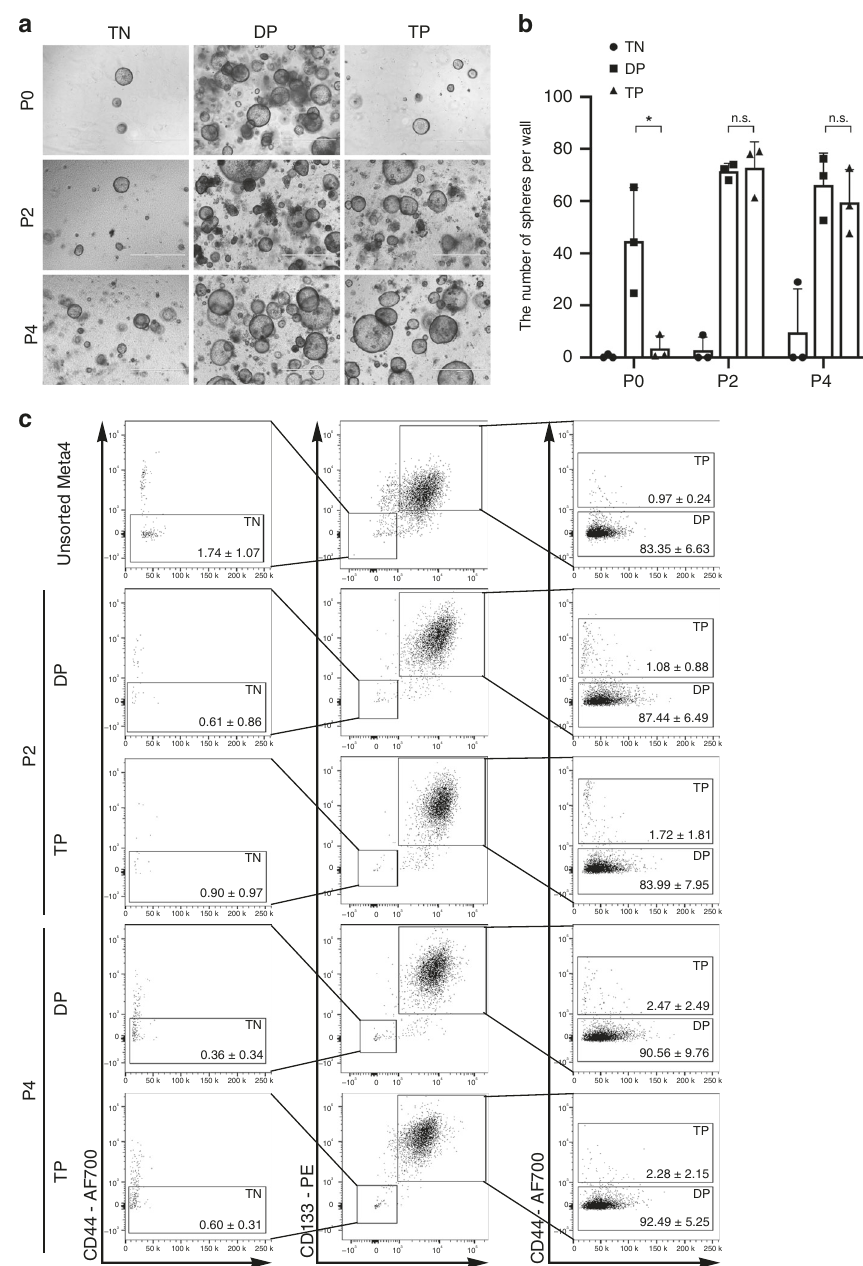
Fig. 9 Expansion of spheres derived from single dysplastic stem cells in Meta4. a Phase contrast images of spheres derived from isolated Triple-negative (TN), Double-positive (DP) or Triple-positive cells (TP) at passage 0 (P0), 2 (P2) and 4 (P4). Images were captured at about 1 week after plating (P0), at day 5 of P2, at day 5 of P4. TN (CD44neg/CD133neg/CD166neg) cells were isolated as a control population. Scale bars indicate 1000 μ m. b Quantitation of the number of spheres formed from the Triple-negative (TN), Double-positive (DP) or Triple-positive (TP) cells at P0, P2, and P4. Data are presented as mean values with standard deviation ( n = 3). P -values were calculated using paired two-tailed t -test. * P = 0.048 (DP vs. TP at P0); n.s., not signi fi cant. c Representative FACS pro fi les of the Triple-negative (TN), Double-positive (DP) and Triple-positive (TP) cells analyzed in unsorted Meta4 organoids and spheres derived from isolated DP or TP cells at P2 and P4. CD44 positive gate was used to distinguish DP and TP cells (right graphs) among CD133 + / CD166 + cells (top right boxes, middle graphs) or to distinguish TN cells (left graphs) from CD133neg/CD166neg cells (bottom left boxes, middle graphs). The percentage of each TN, DP, and TP cells was not signi fi cantly different between unsorted Meta4, DP and TP at P2, and DP and TP at P4. Source data are provided as a Source Data fi